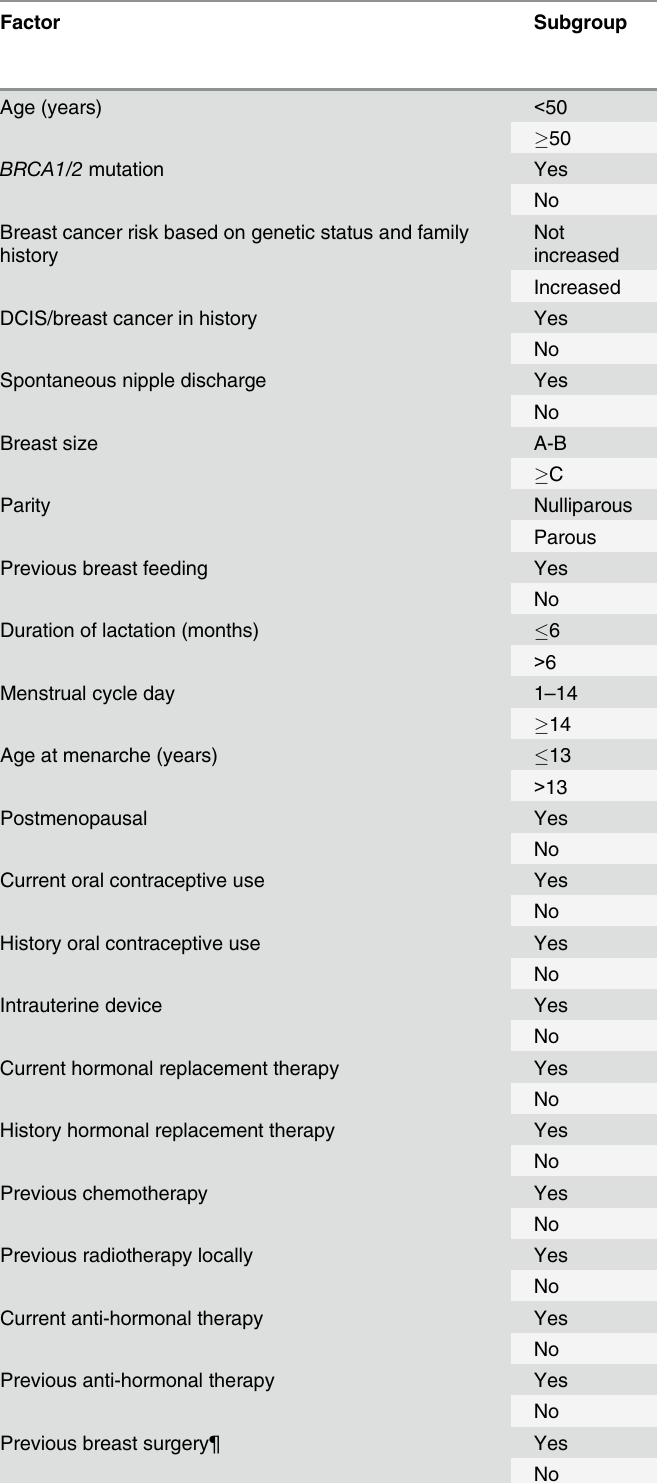
Table 2. Predictive factors for successful NFA per 1824 attempts per breast using repeated measurement analysis.